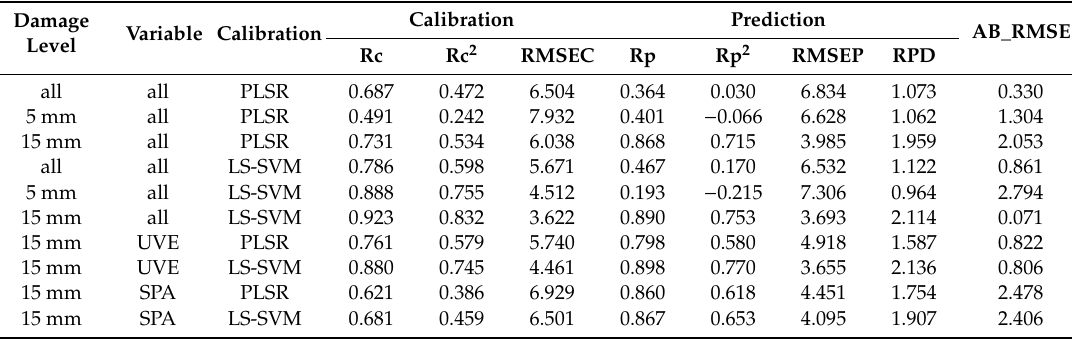
Table 5. Prediction of time after compression